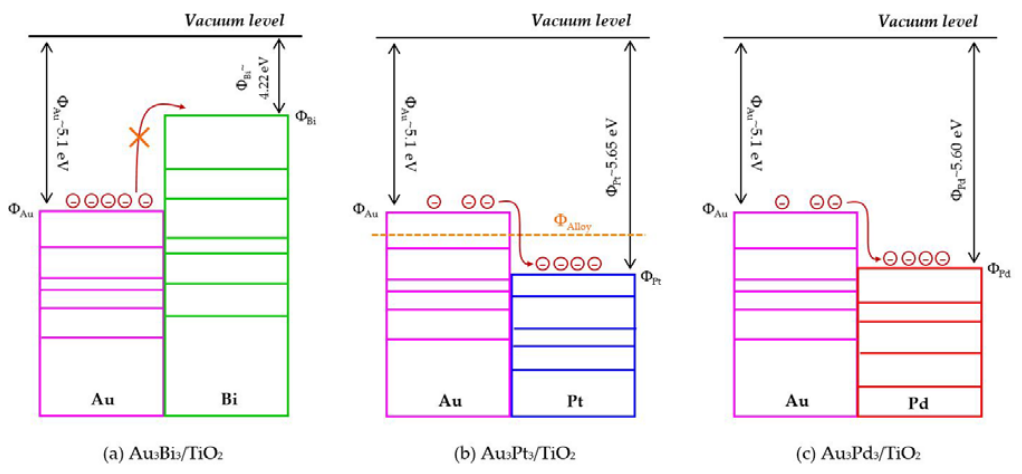
Figure 14. Schematic profiles of the contact metal with work function in the bimetallic NPs